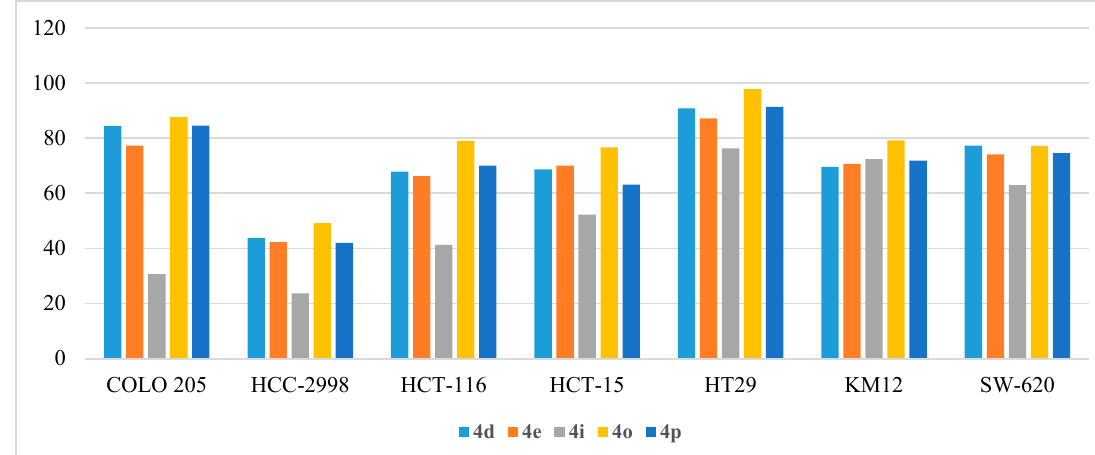
Figure 7. Anti-proliferative activities (% GI) of compounds 4d , 4e , 4i , 4o , and 4p against colon cancer cell lines.